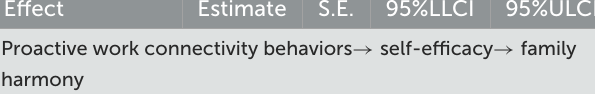
TABLE 7 Results for moderated mediation